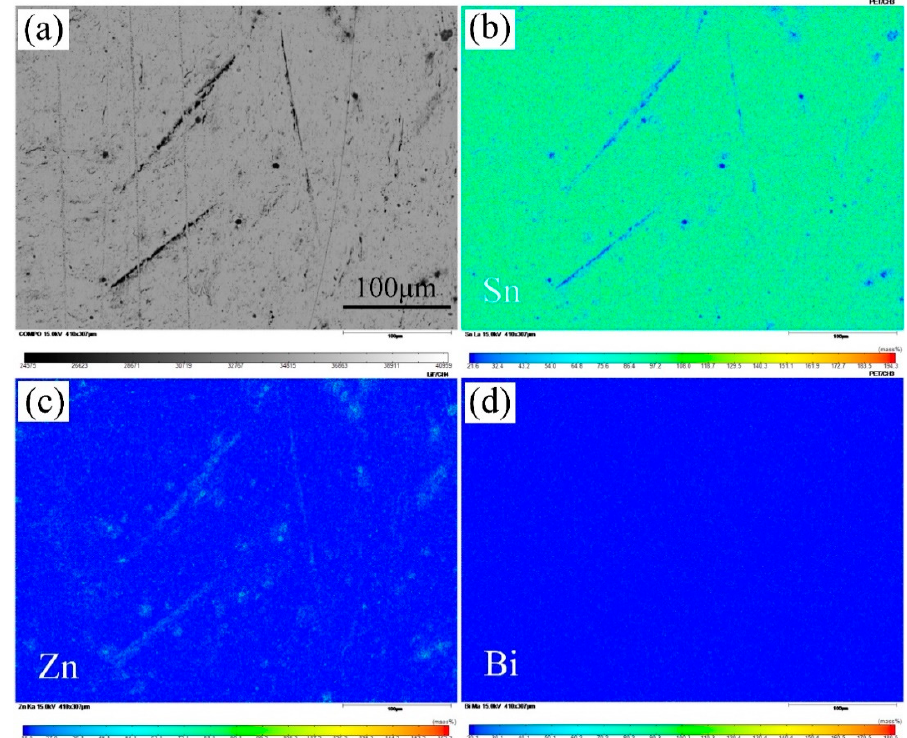
Figure 3. EPMA images and map analyses of the interface of Sn-9Zn-3Bi: ( a ) BSE images; ( b ) Sn element; ( c ) Zn element; ( d ) Bi element.